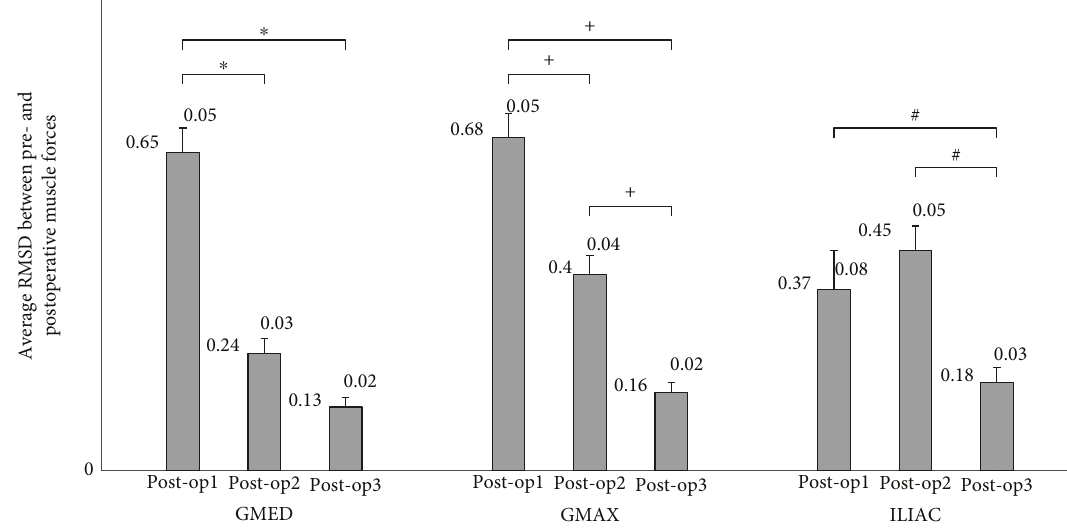
Figure 2: Mean ( ± standard deviation) root mean square di ff erence (RMSD) values between the pre- and three postoperative muscle forces. ∗ , +, # denote the statistical signi fi cance among intragroup comparisons.